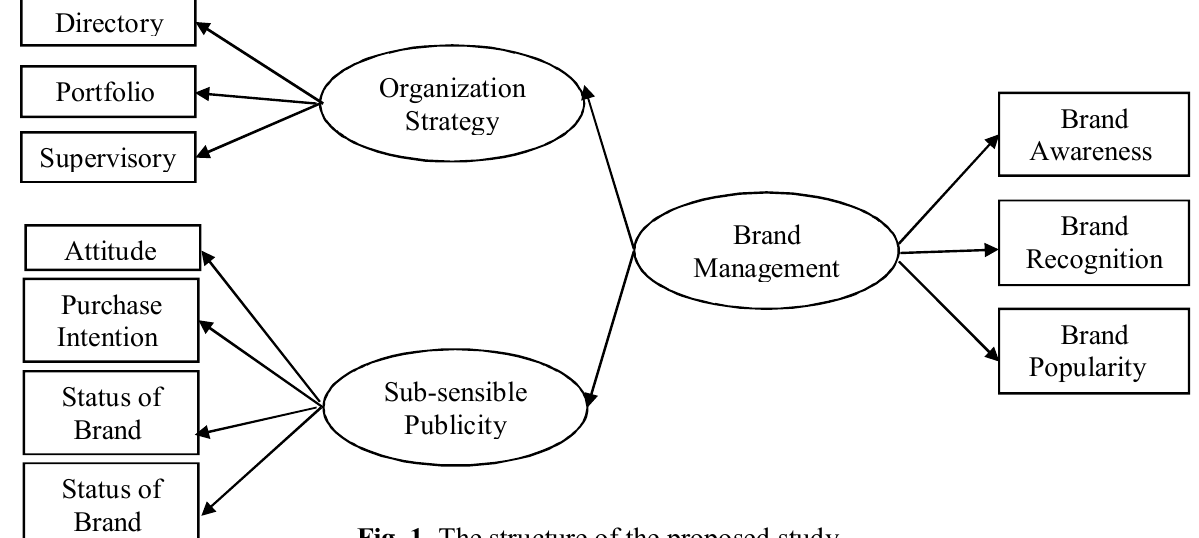
Fig. 1. The structure of the proposed